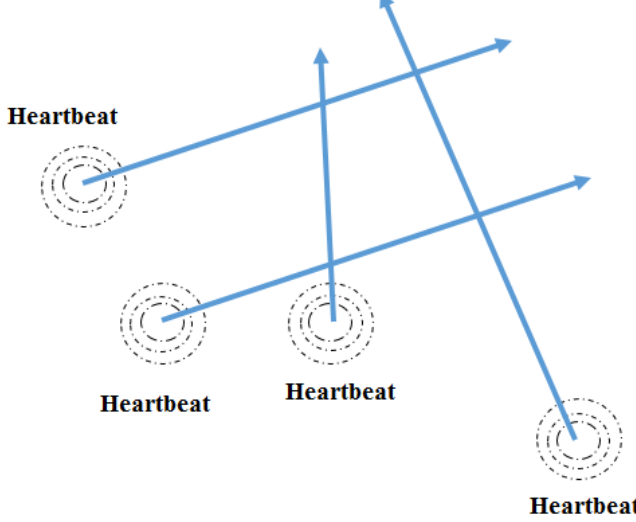
Figure 3. UAVs performing collision avoidance cooperatively through shared HB.